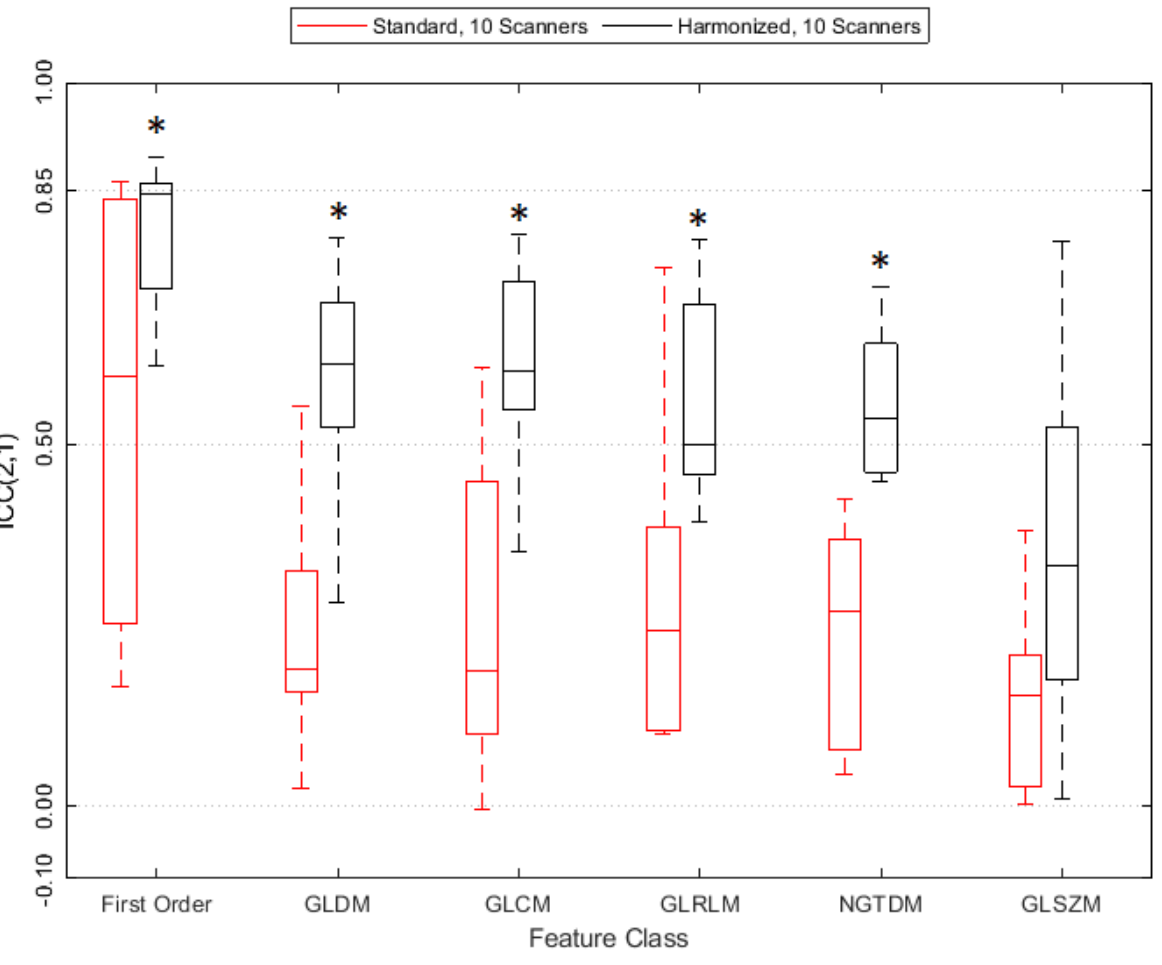
Figure 5. ICC(2,1) values grouped by radiomics feature class. A star (*) indicates statistical significance according to the paired Wilcoxon signed-rank test.